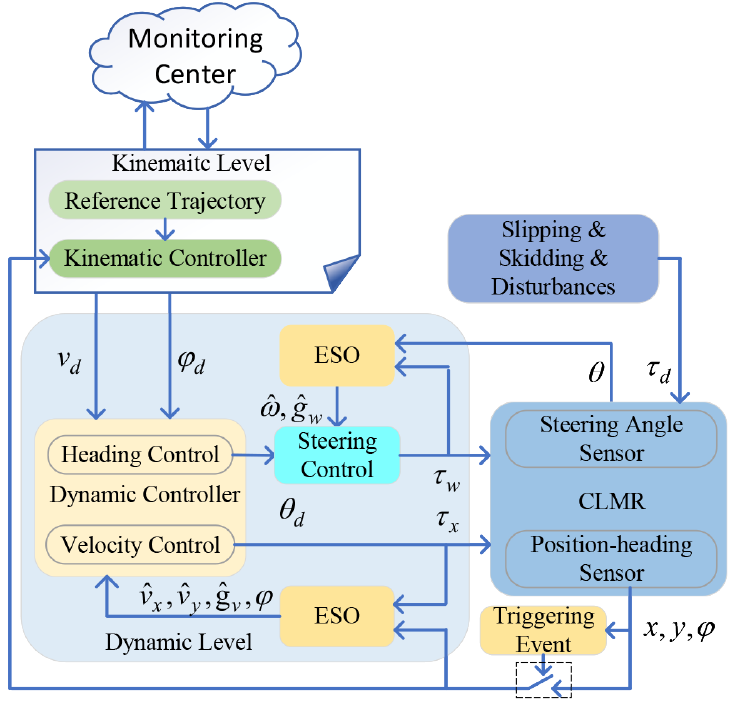
Figure 2. Scheme diagram of the